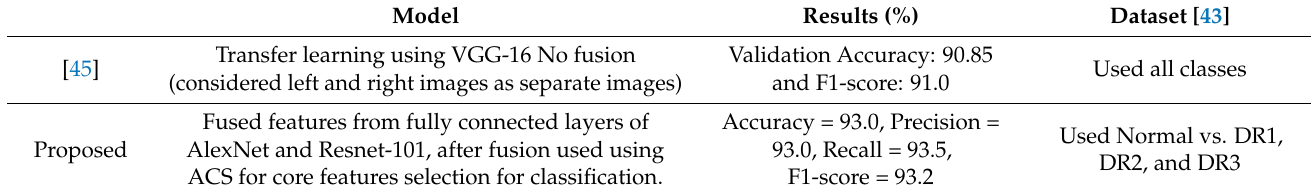
Table 4. Comparison from previous model.